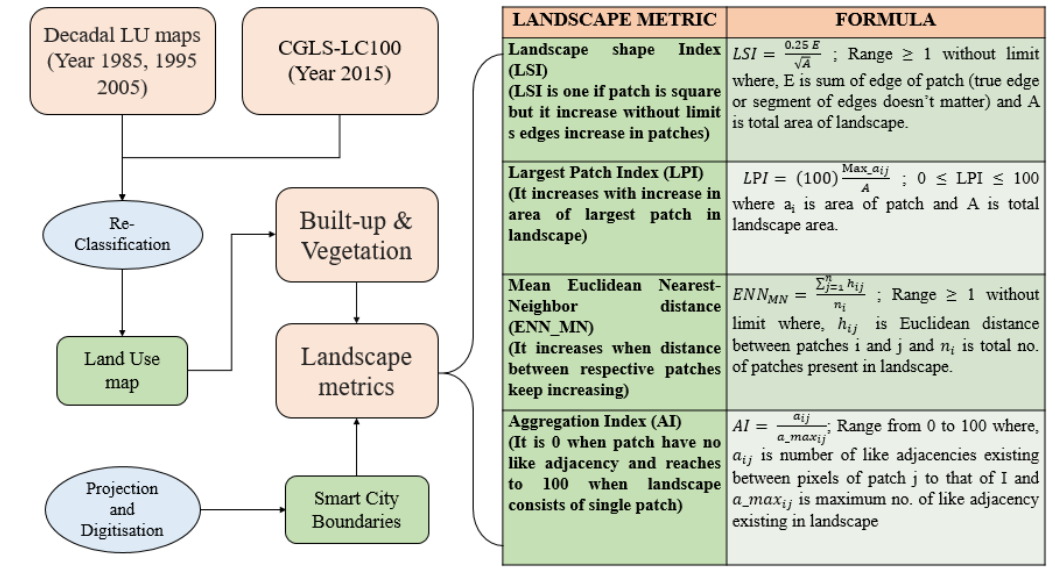
Figure 2 . Flow chart showing methodology used in